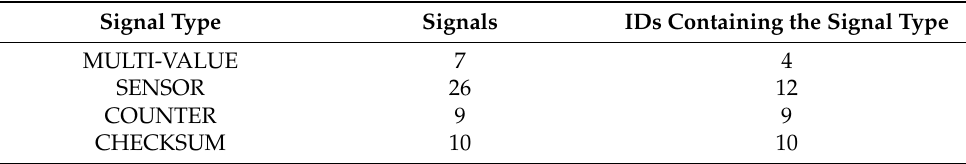
Table 5. Example of signals included in a CAN ID of the real CAN